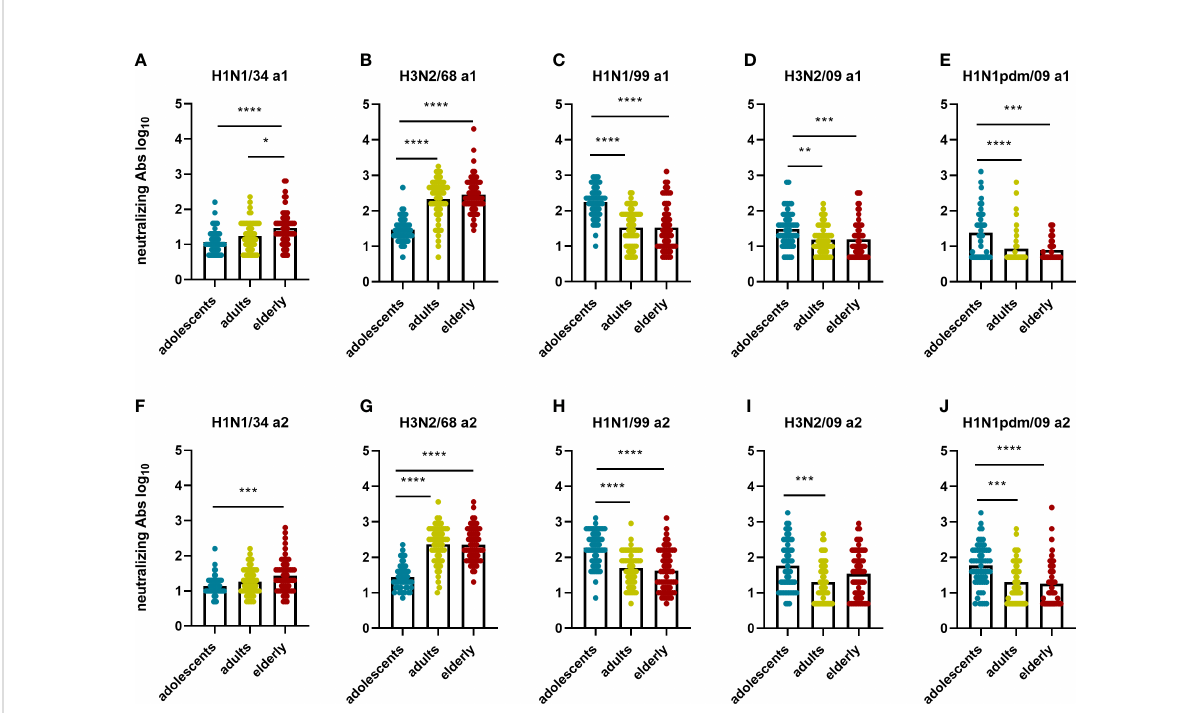
FIGURE 5 Birth year-related differences in neutralizing antibody titers per virus strain. The neutralizing antibody titers measured in the different age groups for each of the 5 in fl uenza virus strains at a1 (A – E) and a2 (F – J) are displayed. Data were analyzed using Kruskal Wallis test followed by Dunn ’ s post-hoc test for multiple comparison. *P ≤ 0.05; **P ≤ 0.01; ***P ≤ 0.001; ****P ≤